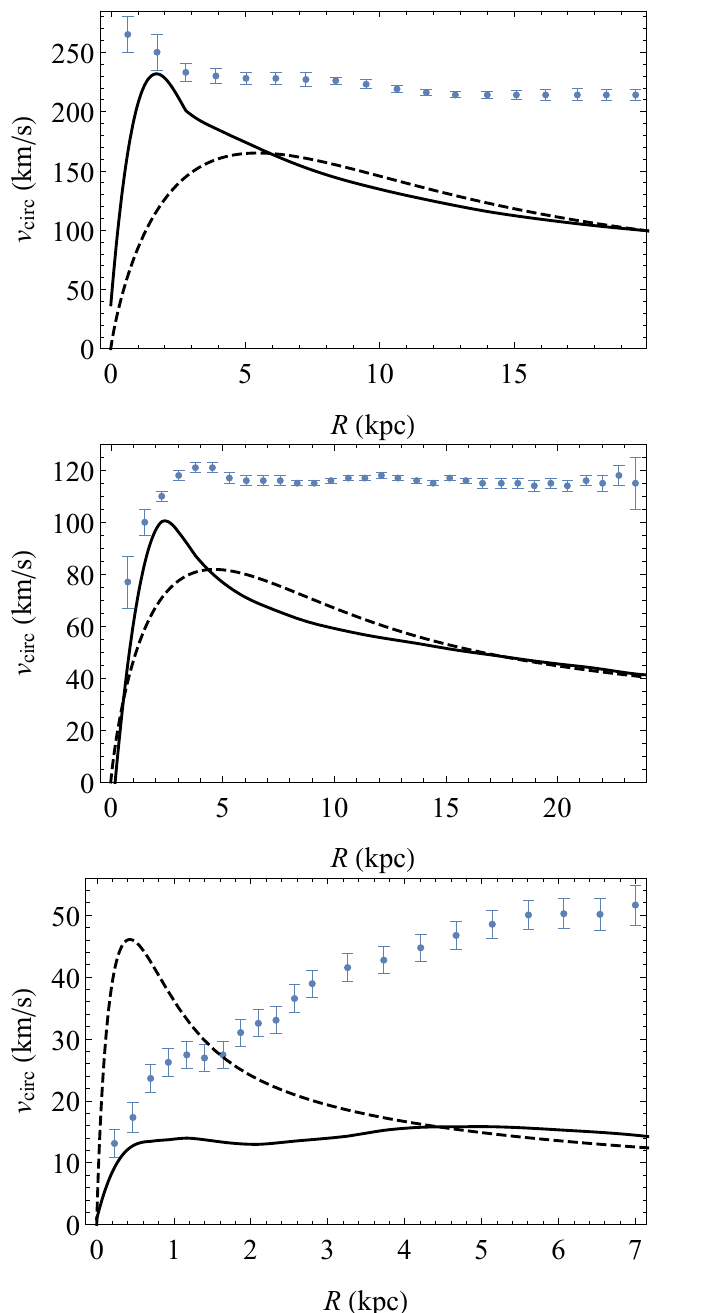
Figure 10 . SPARC data points for the rotation curves of NGC7814 (top panel), NGC6503 (mid- dle panel) and NGC3741 (bottom panel) compared with the prediction of Einstein’s theory using the observed baryonic mass distribution (solid curve) or the exponentially decaying thin-disk pro- file (A.31) (dashed